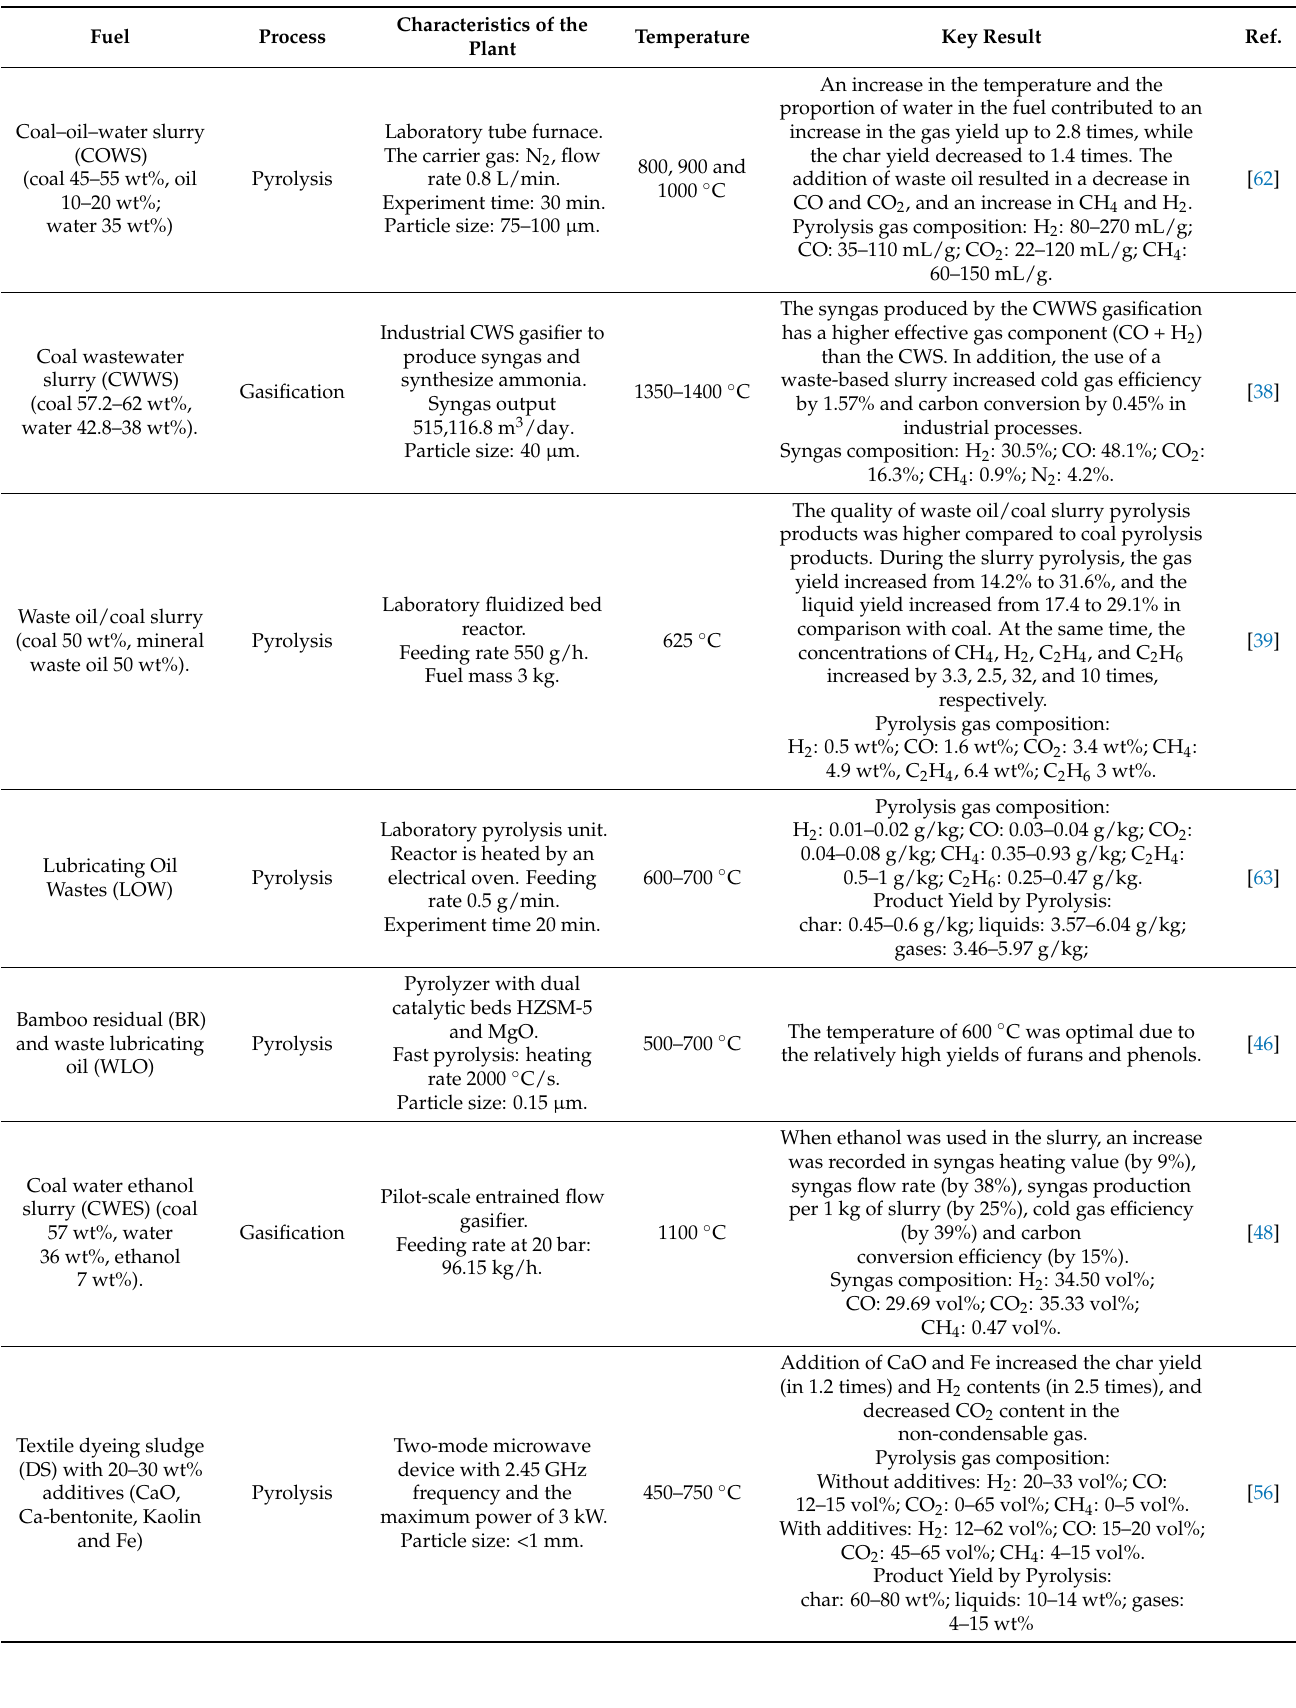
Table 3. Studies of pyrolysis and gasification of mixed fuels carried out via pilot, laboratory, and industrial